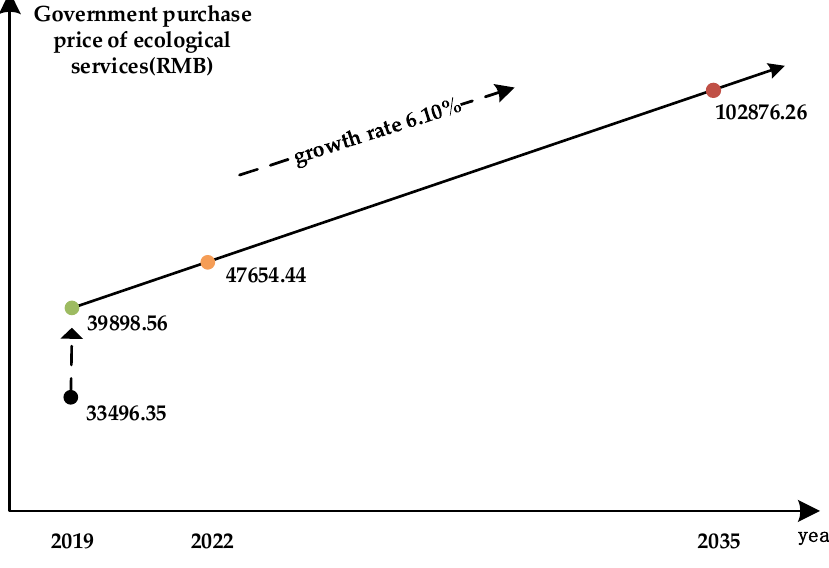
Figure 5. The price strategy of government purchasing of ecological